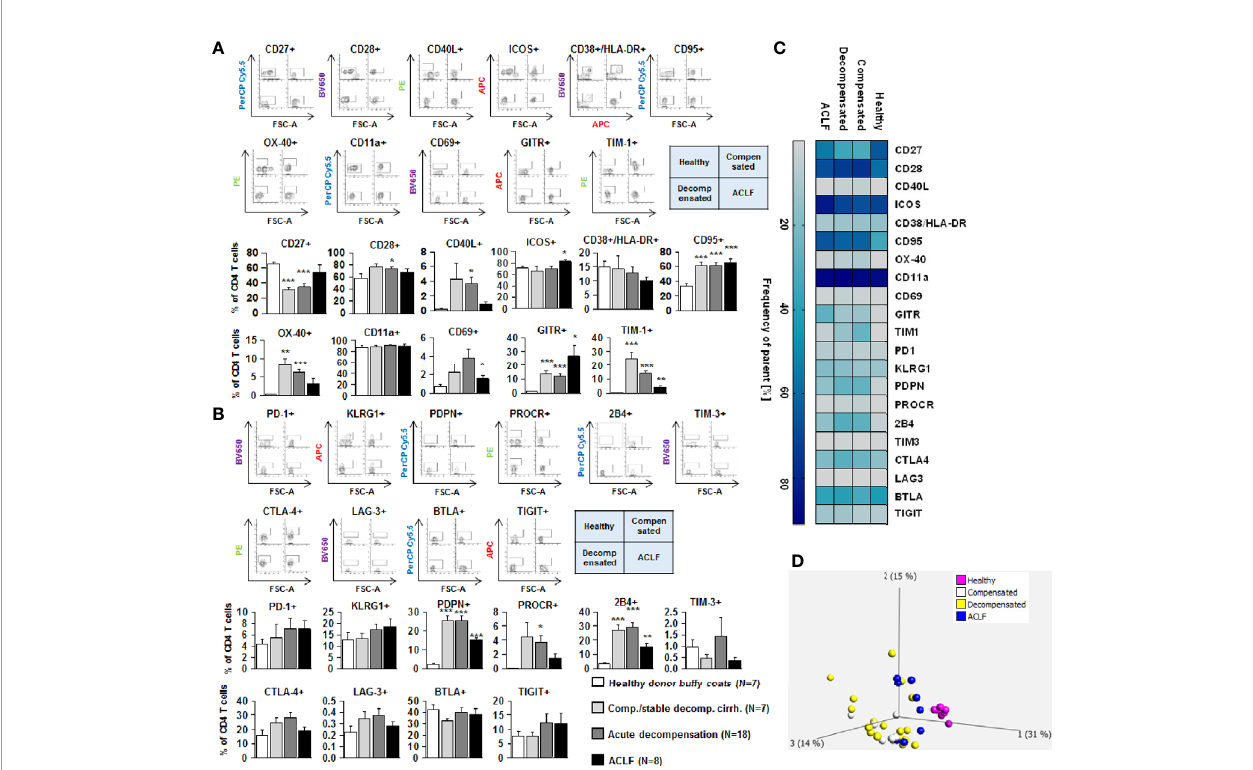
FIGURE 4 | Parallel upregulation of co-stimulatory and inhibitory immune checkpoints on CD4+ effector T cells during the course of liver cirrhosis. Expression of co-stimulatory immune checkpoints, T cells activation markers (CD38/HLA-DR, CD69) as well as of the Fas-ligand CD95 on effector CD4+ T cells are shown in (A) , while expression of inhibitory immune checkpoints is shown in (B) . Typical examples of dotplots of fl ow cytometric analysis of healthy controls or patients with compensated liver cirrhosis, decompensated liver cirrhosis or ACLF are shown in the upper panels whereas mean values and standard deviations are shown in graphs in lower panels. (C) Heatmap summarizing the mean frequencies of positive cells. (D) Principle component analysis of the assessed markers showed distinct clustering of patients with liver cirrhosis versus healthy controls whereas no clear clustering was observed between the stages of liver cirrhosis. Values are displayed as frequency of parent. * P <0.05, ** P <0.01, *** P